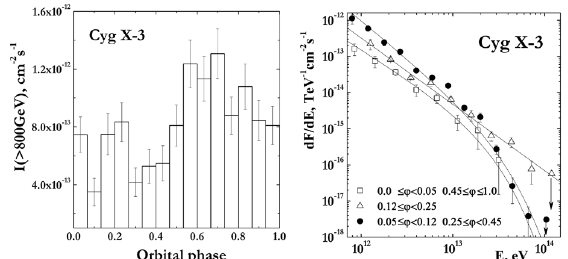
Figure 2. left: The SHALON light curve of Cyg X-3 folded with the orbital period of 4.8 h. right: The di ff erential γ -ray spectra for Cyg X-3 at very high energies in di ff erent intervals of orbital modulation. The lines represent the fit to each spectrum.